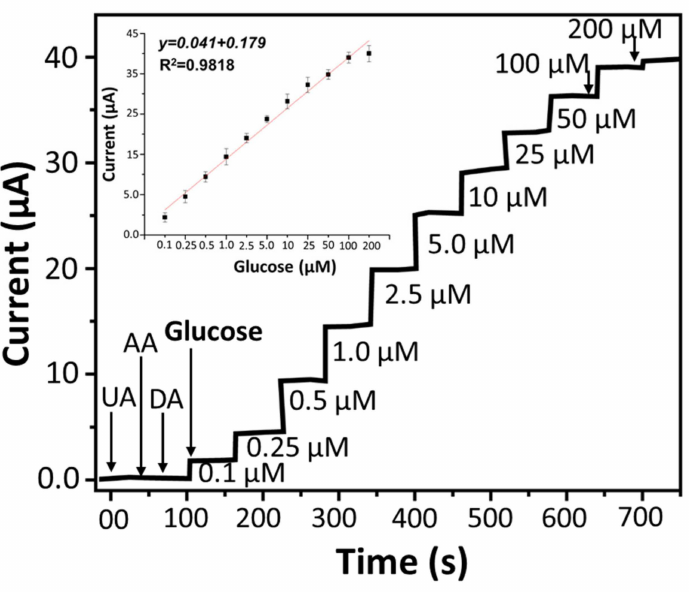
Figure 5. Amperometric response of NEGS with different conc. of glucose added in 0.1 M NaOH (pH 13) with 30 s of intervals. NEGS show no current response upon addition of different interference such as uric acid (UA), ascorbic acid (AA), Dopamine (DA) at a concentration of 50 µ M of each, while a linear current response with varying glucose concentrations were clearly observed (inset calibration graph of current response vs. glucose